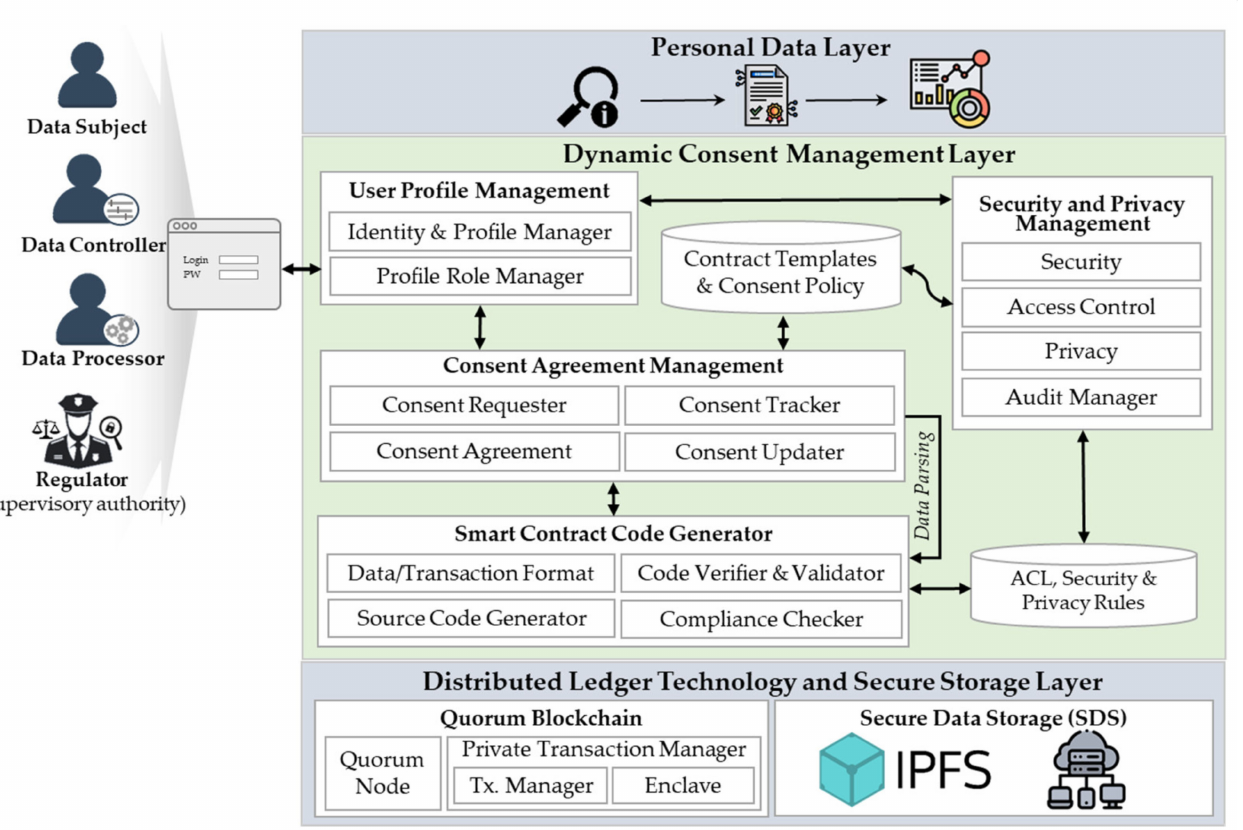
Figure 3. Smart-contract-based dynamic consent management system layered